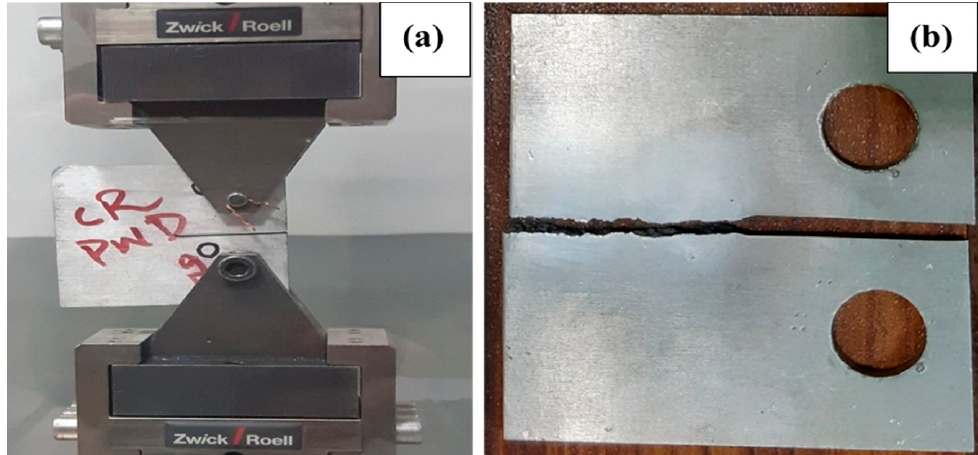
Figure 2. ( a ) Fatigue testing of C(T) sample ( b ) Break sample after fatigue test.